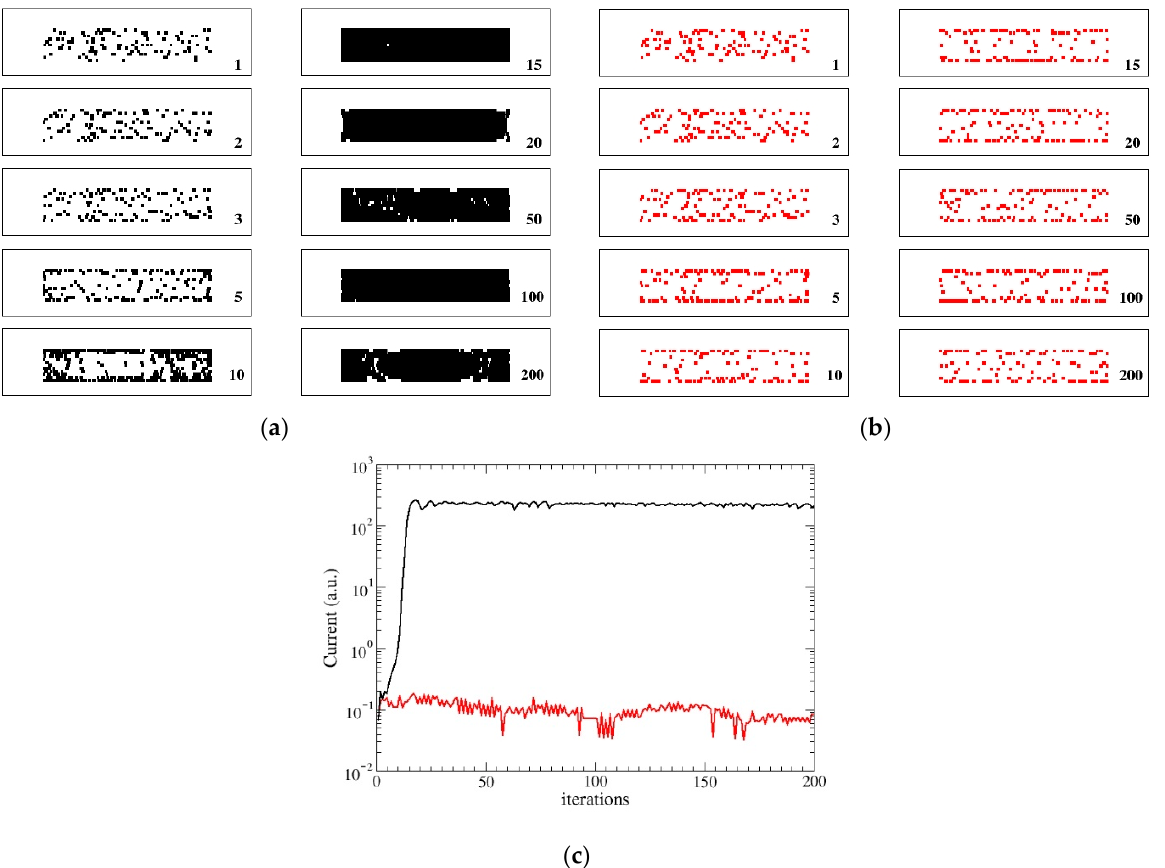
Figure 2. Colony formation in a rectangular lattice. The initial percentage of seeds is 5% of the maximal space occupancy. In the transition region (here σ = 21.5), the system can exit into a simple migration ( a ) or a colony formation ( b ). Each screenshot of ( a ) and ( b ) is obtained at a different iteration time, from 1 to 200. ( a ) Screenshots of the migration evolution of an initial seed distribution. In the first three screenshots seeds (black pixels) simply migrate. ( b ) Colony formation with same conditions as in Figure 1a. ( c ) Monitoring of the QS signal. The electrical current of the network mirrors the QS for the development of a colony (black), and a migration (red).